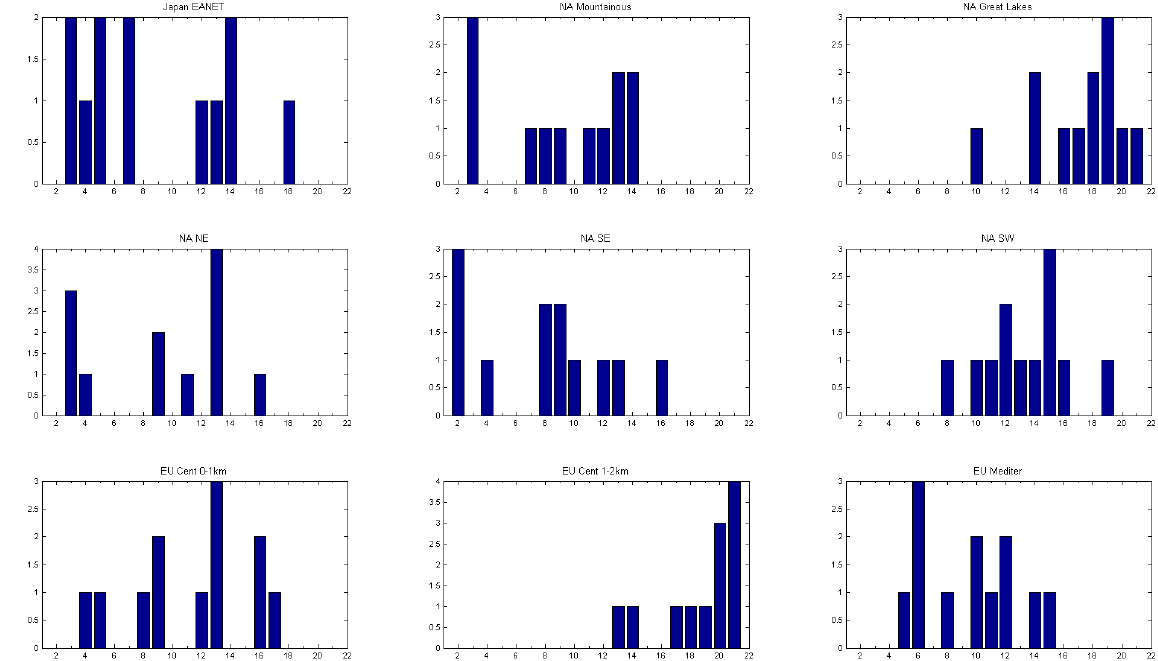
Figure 2. Ranked histogram for the nine subregions subject to MM ensemble